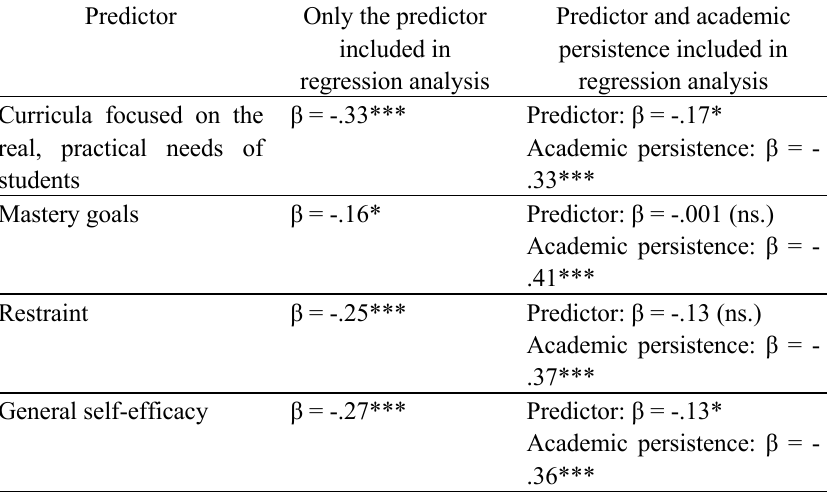
Table 2. Results of the mediation analysis with Dropout intentions as outcome in the IB